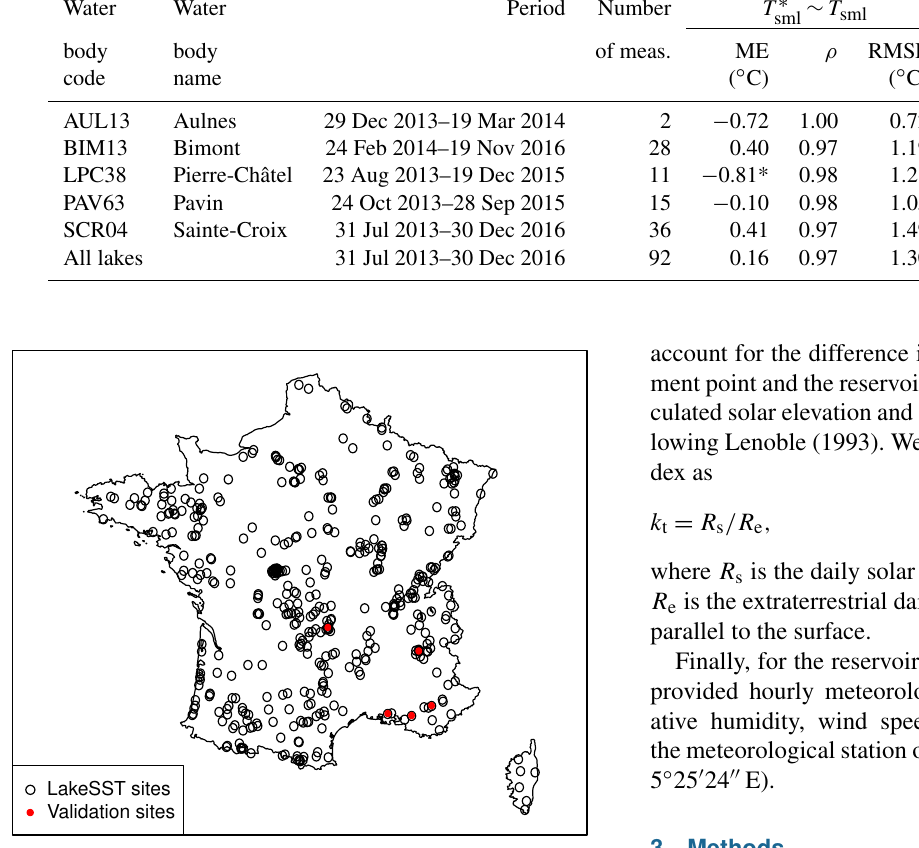
Figure 1. Location of the water bodies included in LakeSST and validation